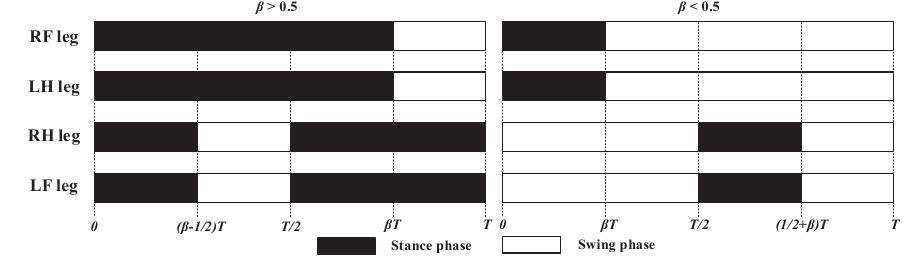
Figure 7. The leg phases of the trot gait.